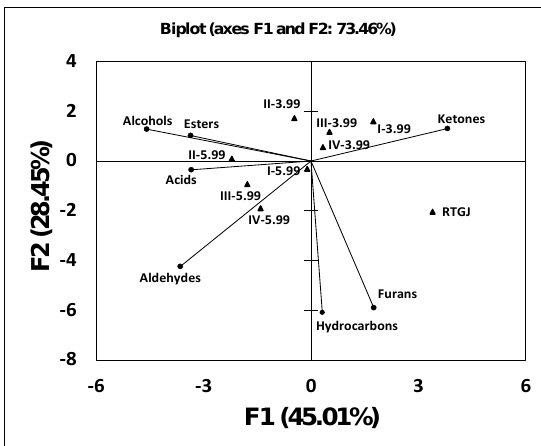
Figure 5. Principal component analysis of volatile compound families (Table 6) in the nonfermented red table grape juice (RGTJ) and fermented samples obtained from fed-batch fermentations A (I − 3.99, II − 3.99, I II− 3.99 and IV − 3.99) and B (I − 5.99, II − 5.99, I II− 5.99 and IV − 5.99).